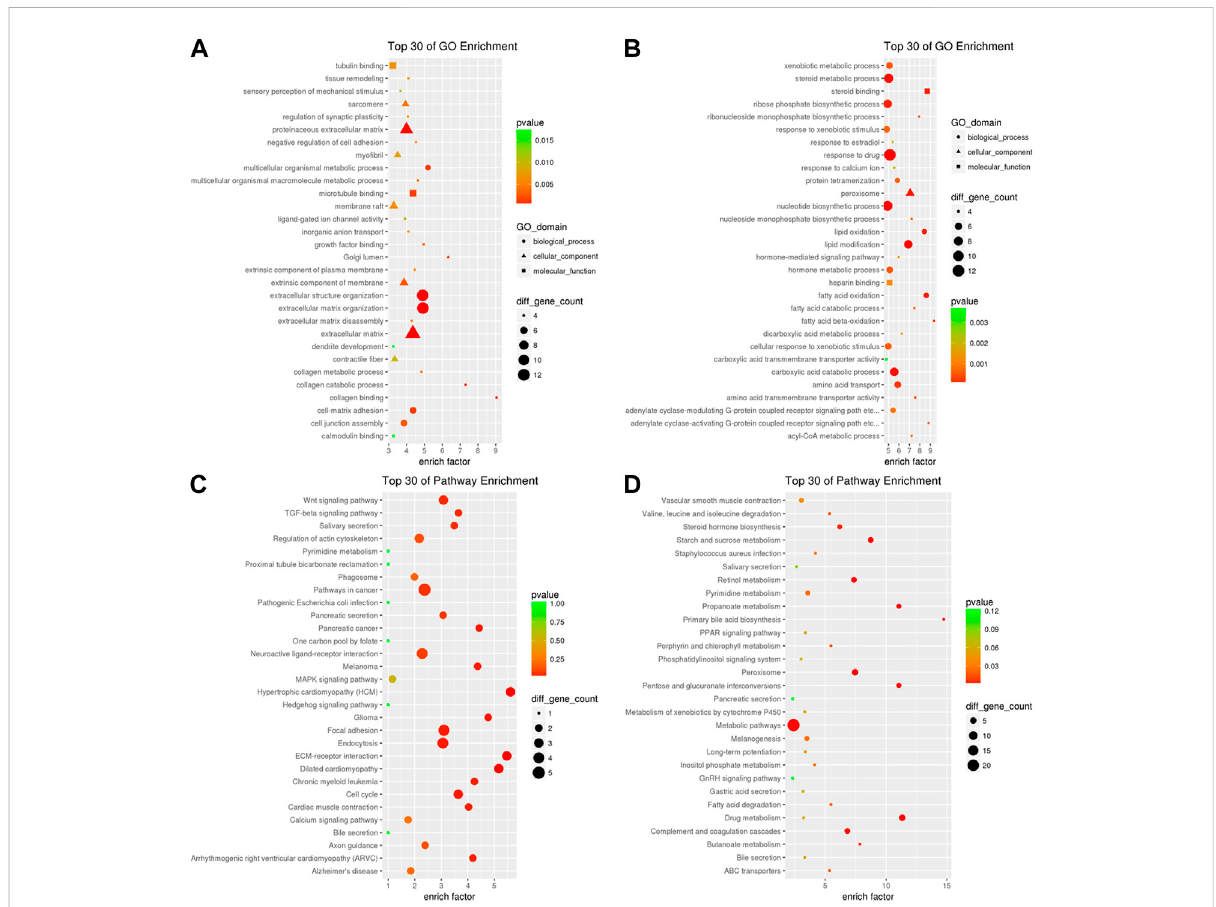
FIGURE 7 GO and KEGG analyses of the DE circRNA-mediated ceRNAs in iCCA. (A) The upregulated mRNAs in the upregulated circRNA-mediated ceRNAs were analyzed with GO analysis. (B) The downregulated mRNAs in the upregulated circRNA-mediated ceRNAs were analyzed with GO analysis. (C) The upregulated mRNAs in the upregulated circRNA-mediated ceRNAs were analyzed with KEGG analysis. (D) The downregulated mRNAs in the upregulated circRNA-mediated ceRNAs were analyzed with KEGG